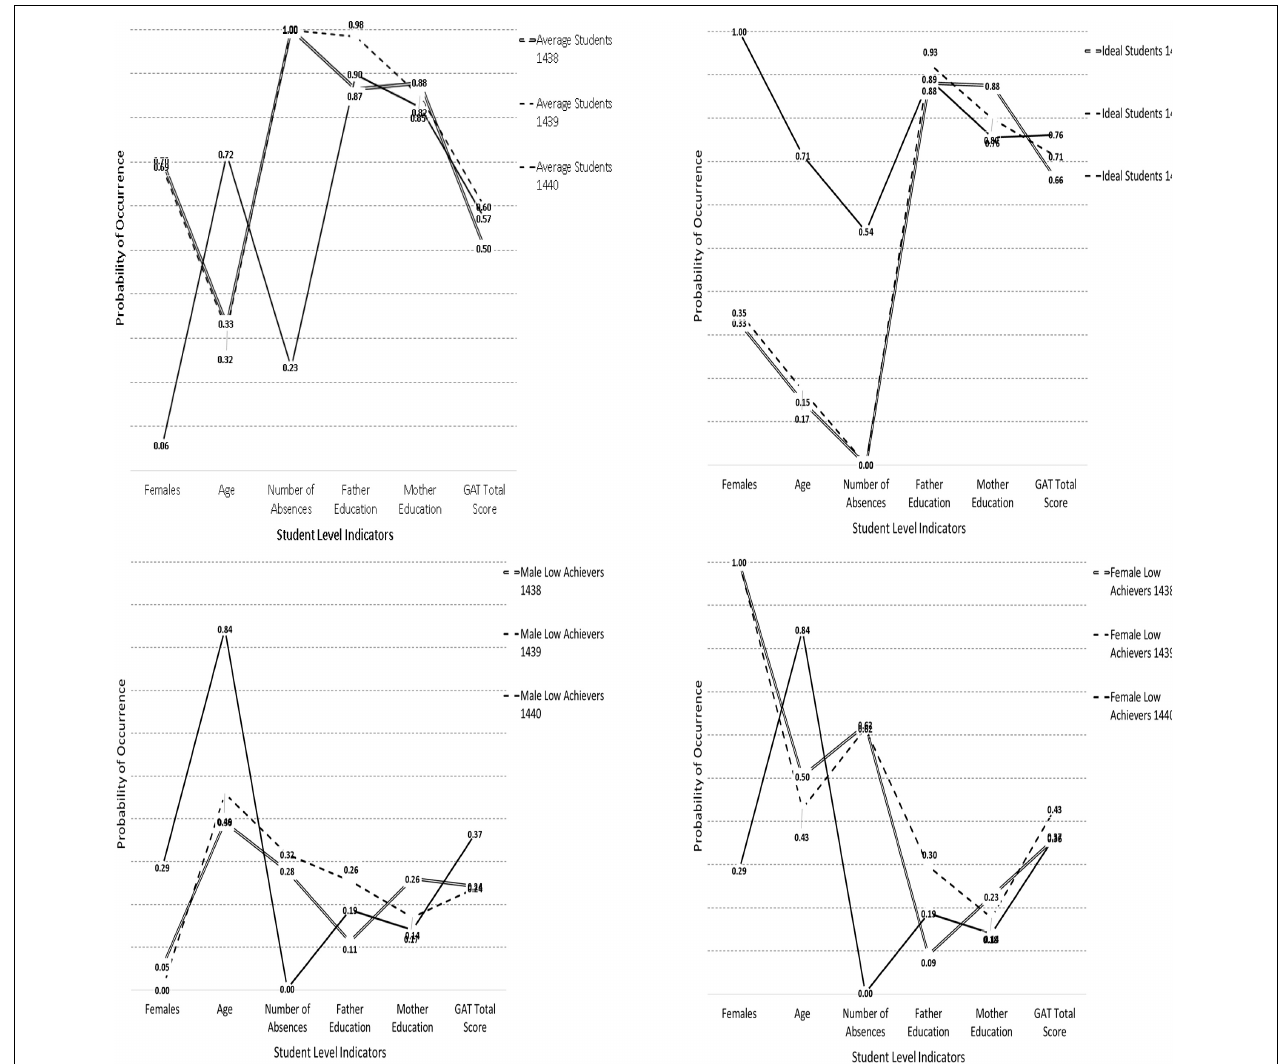
FIGURE 4 | Visual analysis of latent class stability over the years for each one of the 4 latent